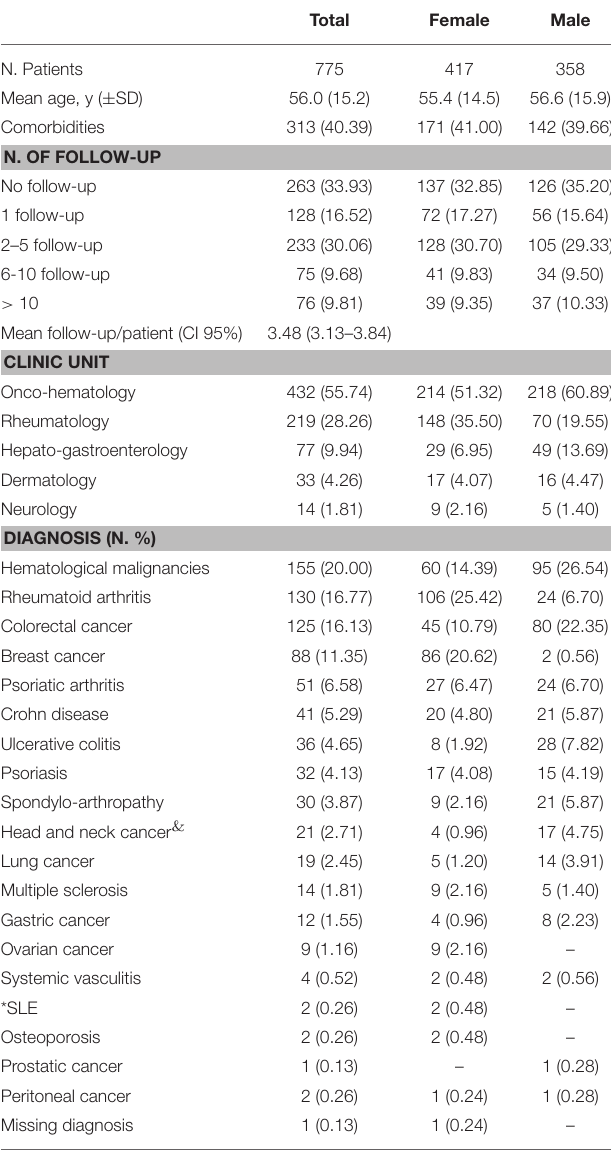
TABLE 1 | Clinical and demographic characteristics of population